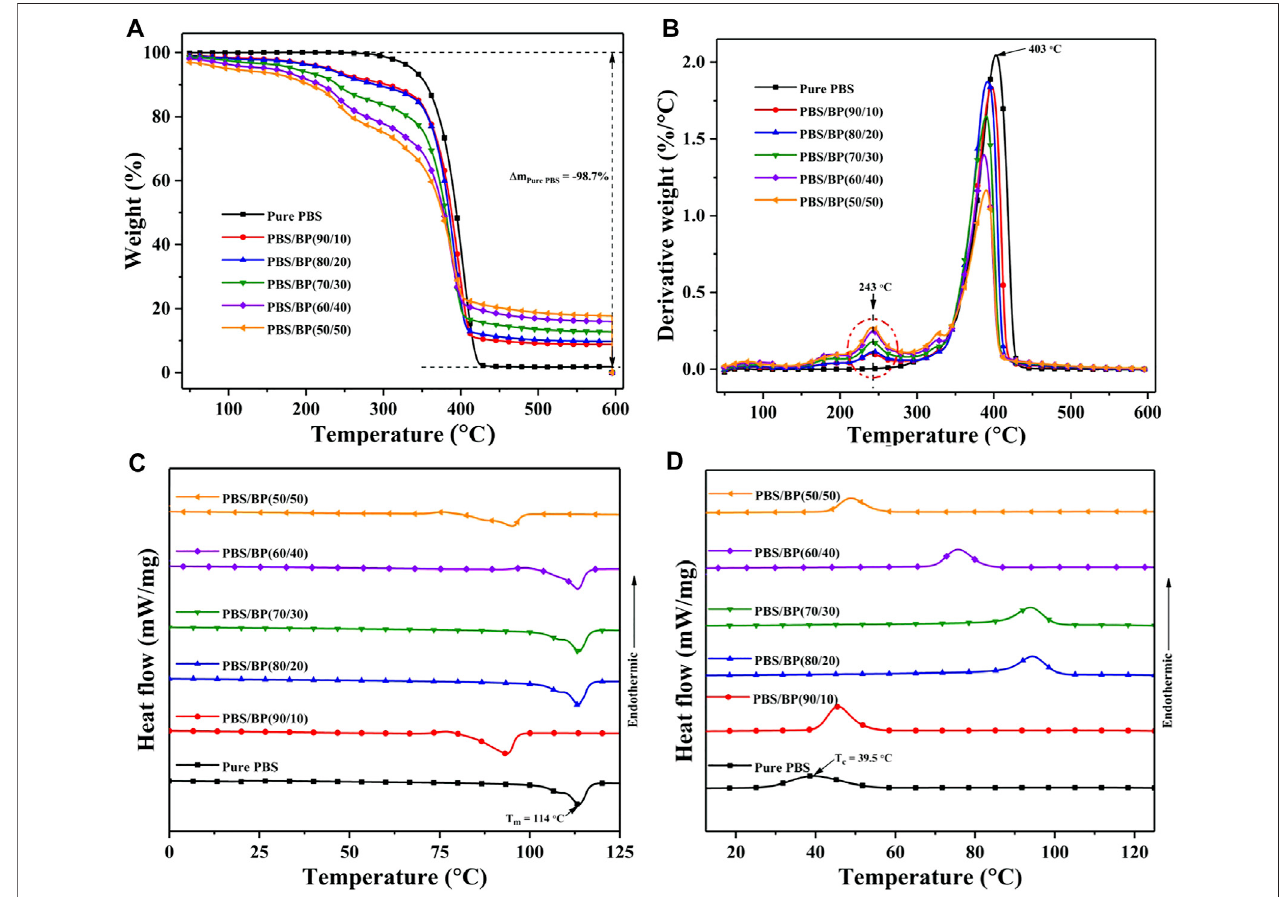
FIGURE 5 | (A) TGA; (B) DTG; (C) DSC cooling curves; and (D) DSC heating curves of pure PBS and PBS/BP blends at varied